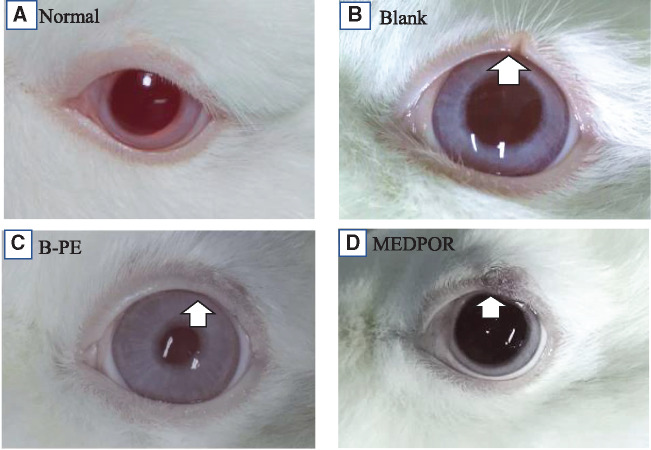
Post-surgery appearance at the fourth week. (A) Normal and (B) blank control. B-PE scaffolds group (C) showed well eyelid repair and Medpor spacers group (D) showed a hard hyperplasia and hyper pigmentation. The white arrows point to the defect sites